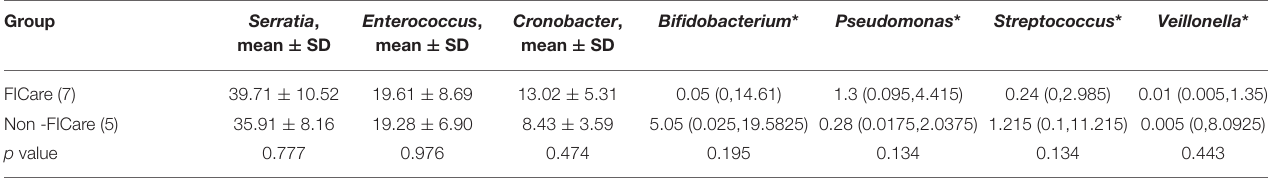
TABLE 3 | Proportions of intestinal flora genera in fecal samples in the two groups. Group Serratia , mean ±